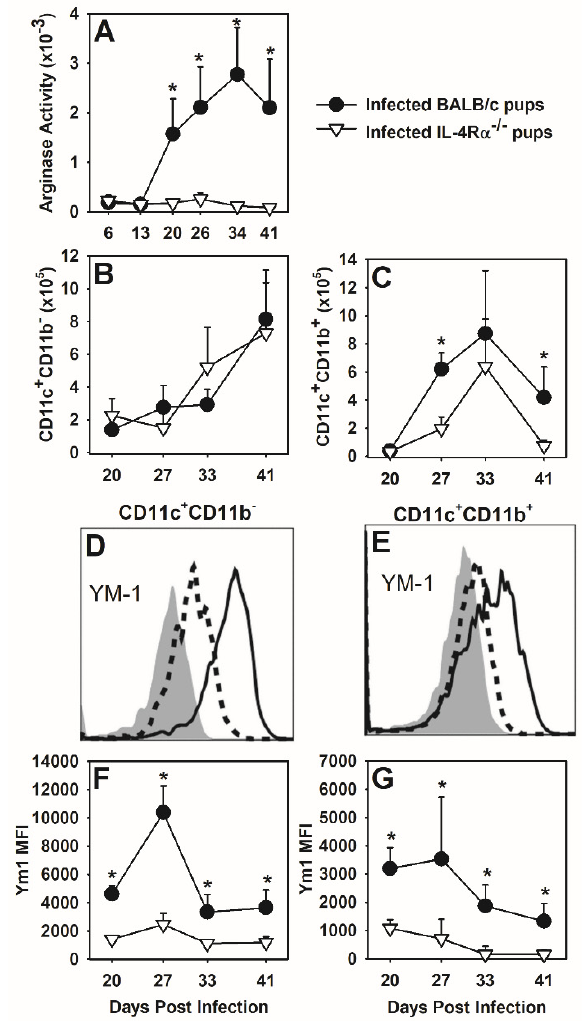
Figure 7. P. murina infected IL-4R α − / − neonates have a reduction in alternatively activated macrophages in the lungs. Two-day old BALB/c and IL-4R α − / − neonates were infected with 5 × 10 5 P. murina organisms per gram body weight. At indicated days post infection, BALF and lung digest were collected from 4–7 mice per group. ( A ) Arginase activity from lung digest lysates was determined as described in materials and methods. ( B – G ) BALF cells were stained with antibody against CD11c, CD11b, and Ym1 and analyzed by flow cytometry. Resident AMs are CD11c + CD11b - and activated AMs are CD11c + CD11b + . Representative histograms from day 27 post-infection depicting Ym1 expression of gated macrophage populations from wild type (solid line) and IL-4R α − / − (dashed line) mice and an isotype control (shaded) is shown ( D , E ). MFI of Ym1 over time is shown in panels F and G. Data represent the mean ± SD and are representative of 2 independent experiments. * p ≤ 0.05 comparing P. murina infected BALB/c neonates to P. murina infected IL-4R α − / − neonates at the same time